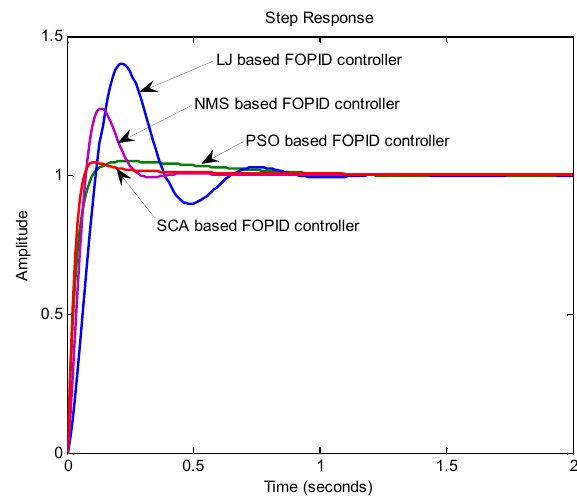
Figure 12. Step response of controlled ROCIP with the FOPID controller.